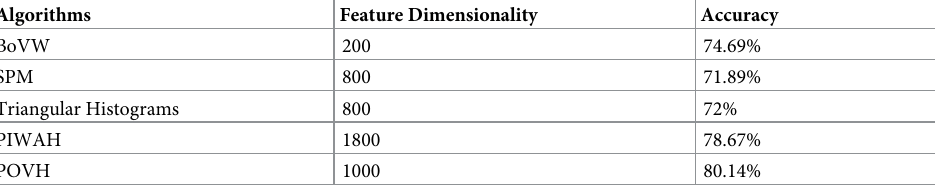
Table 1. Classification accuracy and size of feature vector comparison while using SIRI-WHU dataset. Algorithms